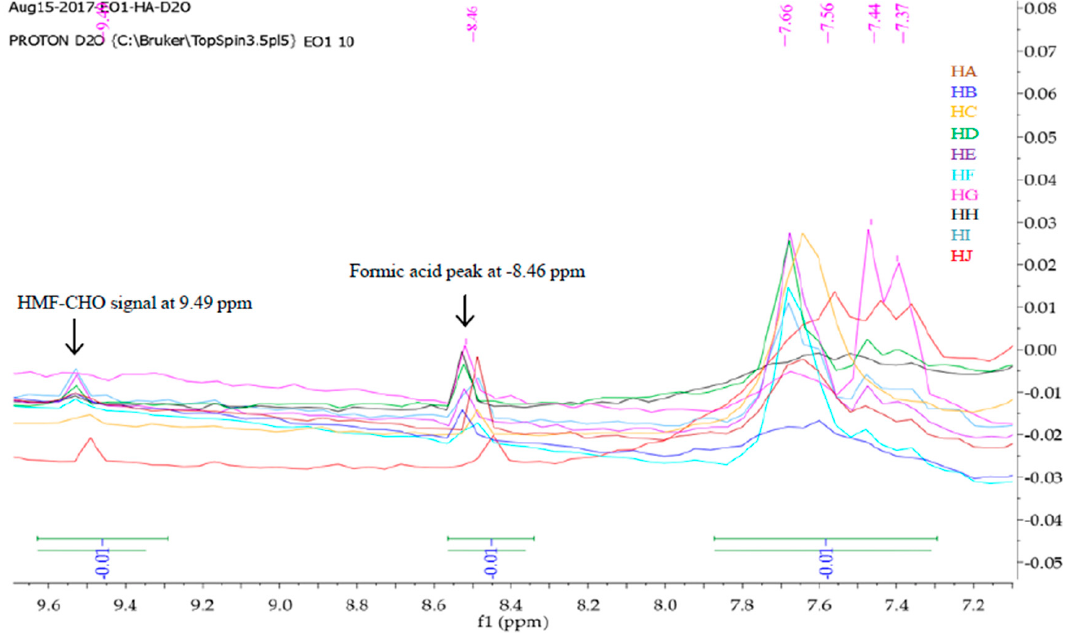
Figure 5. Fingerprints of superimposed and binned 1 H-NMR spectra in D 2 O at region 9.60–7.20 ppm, using Mnova 12 NMR software [49].